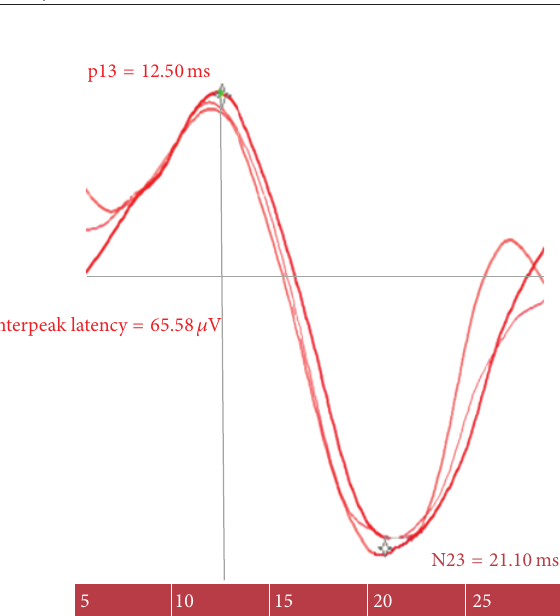
Figure 2: The auditory brainstem response to 500 HZ tone burst ) in an healthy ( ABR 500 HZ